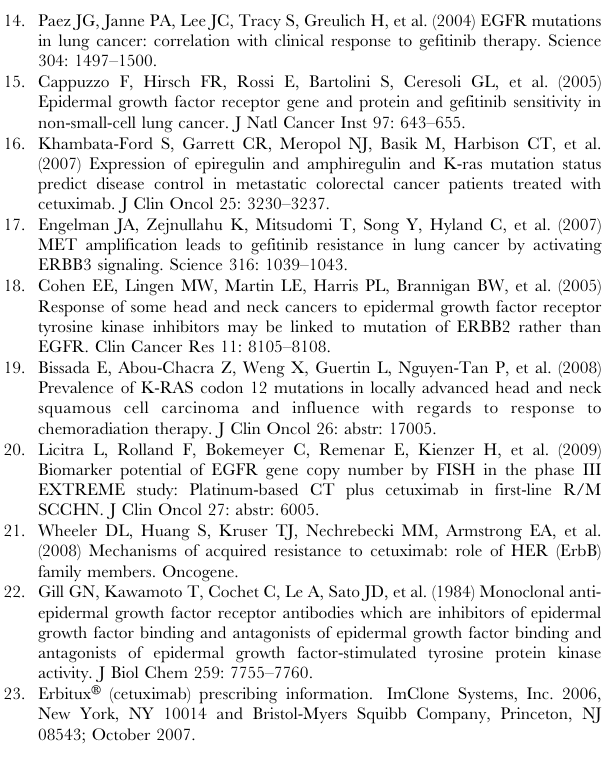
Table S1 Culture media and sources of 34 head and neck cancer cell lines and HaCaT cells.